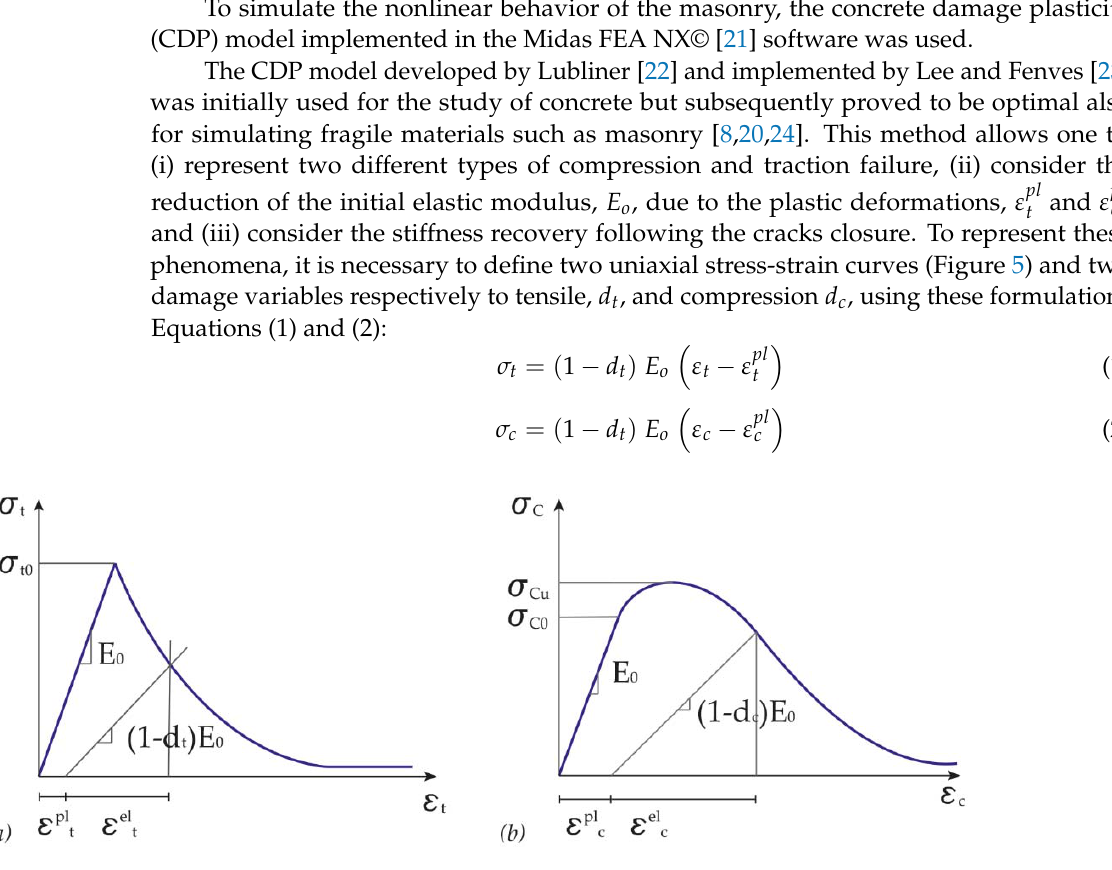
Figure 5. ( a ) Tensile and ( b ) compression mono-axial inelastic curves in the CDP